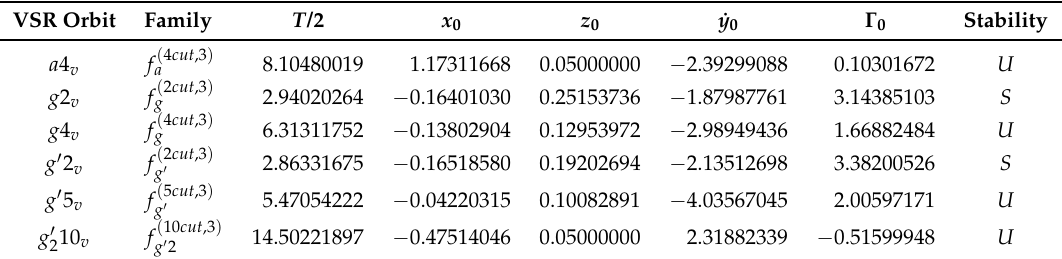
Table 3. Sample members of families of 3D periodic orbits having the O xz − O xz plane symmetry. These families bifurcate from the second vertical intersection with the O x -axis of the corresponding VSR orbits, presented in the first column. The last column indicates whether each family contains stable parts ( S ) or not ( U ) .